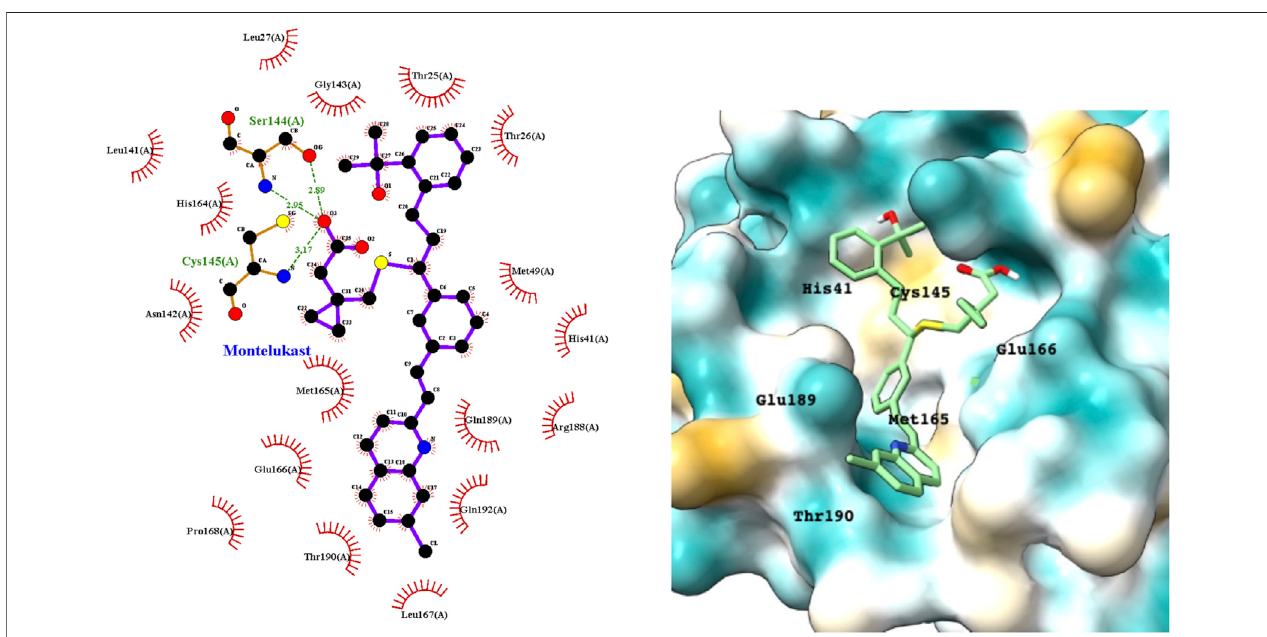
FIGURE 3 | LigPlot (left) and hydrophobic protein surface representation (right) of the main interactions between M pro and montelukast. The molecular surface denotes hydrophobicity of the pockets (blue hydrophilic, yellow/brown hydrophobic). Key binding site residues are labeled to help orient the viewer.